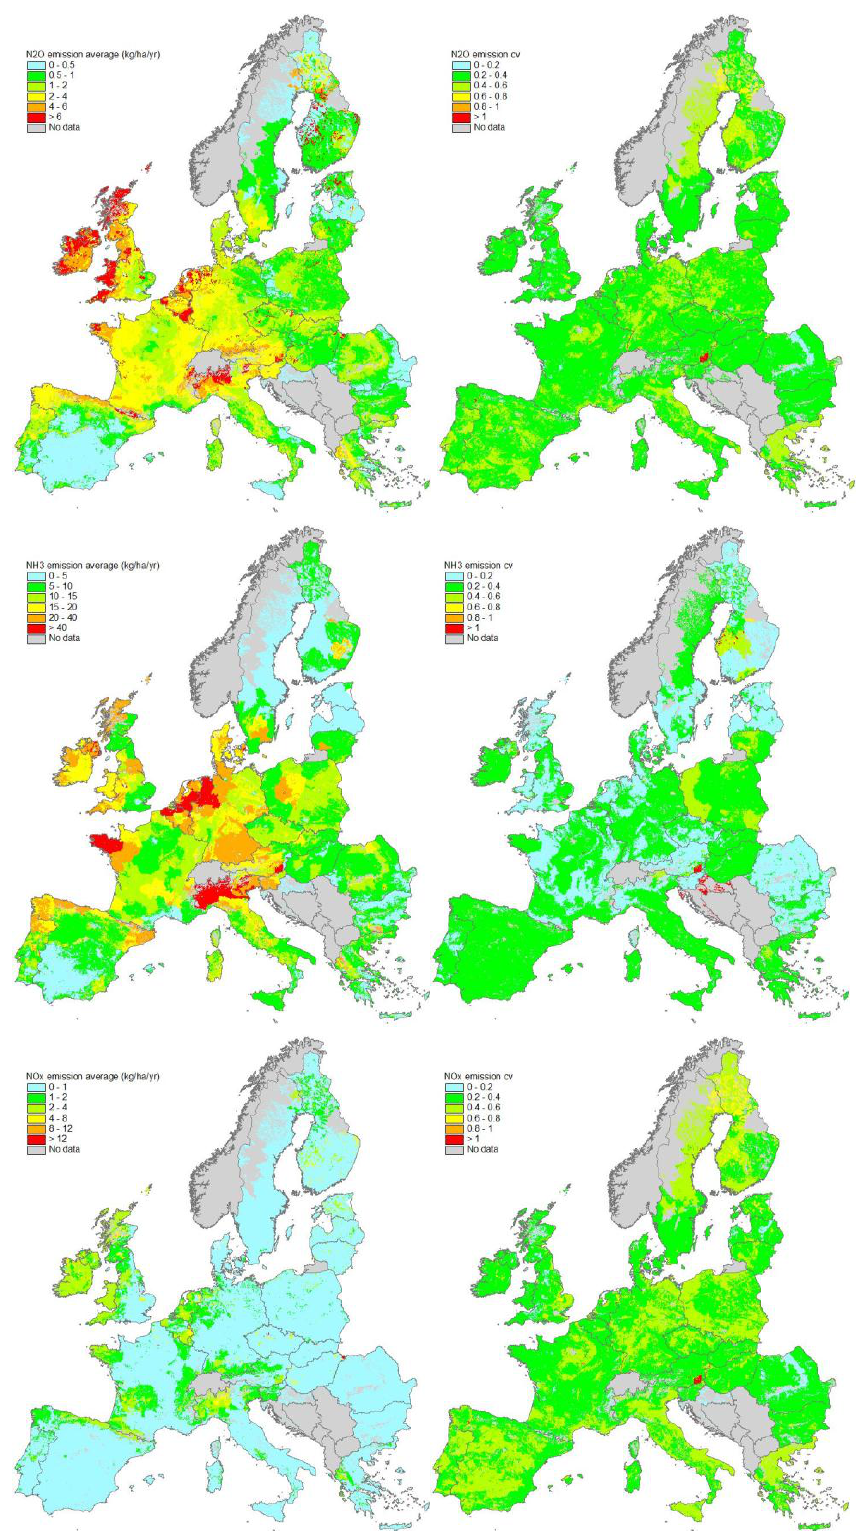
Figure 4 The mean (left) and CV (right) of the area-weighted average N emission (in kg N ha -1 yr -1 ) per NCU for the year 2000. 5